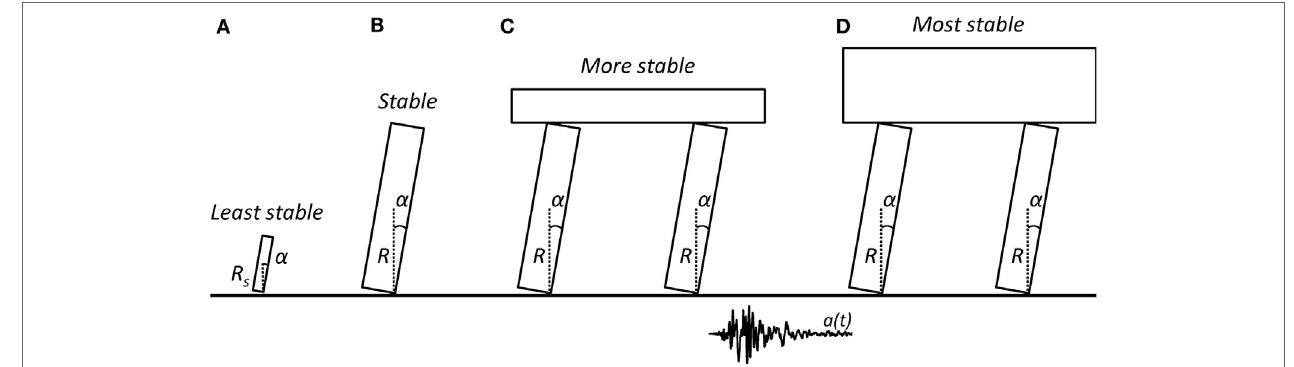
FigUre 1 | Rigid rocking systems: (a) small block; (B) larger block; (c) rocking frame; and (D) top-heavy rocking